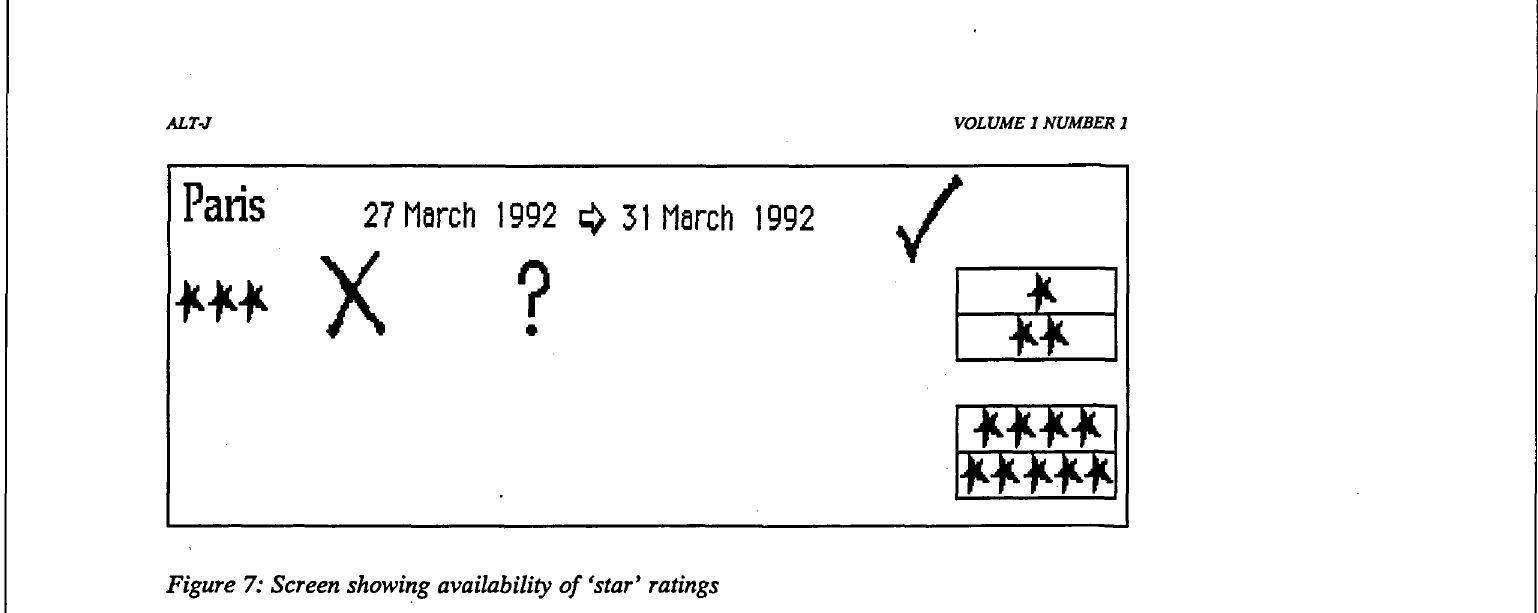
Figure 7: Screen showing availability of 'star' ratings The message is revealed to the hotel in stages. Confirmation of the acceptability of each part of the message (tick) moves on to the next part of the message, whilst unavailability (cross) brings up a range of possible alternatives. Figure 7 shows that the required dates of stay are acceptable but the requested hotel grade is unavailable. The hotel is therefore presented with four options to propose in